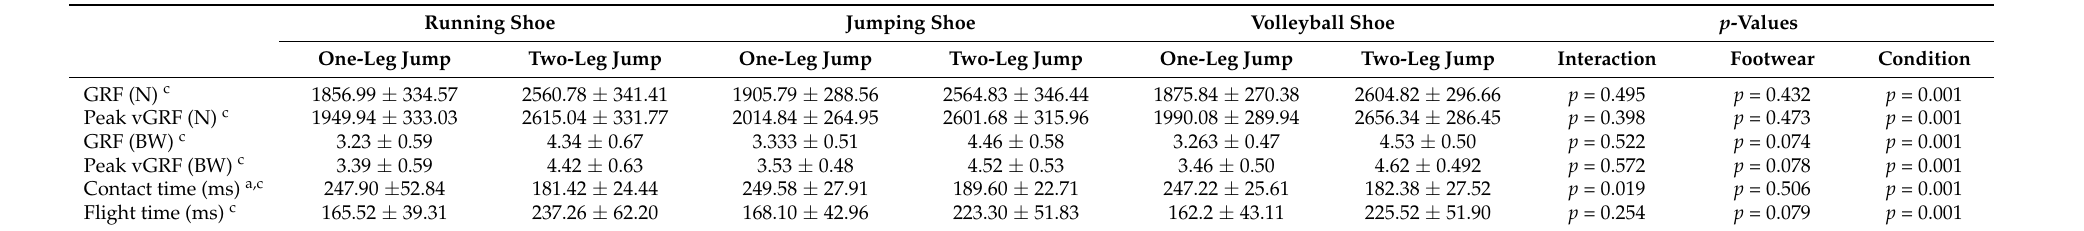
Table 1. The descriptive statistics (Mean ± SD) and statistical result of force platform variables during jump rope task.